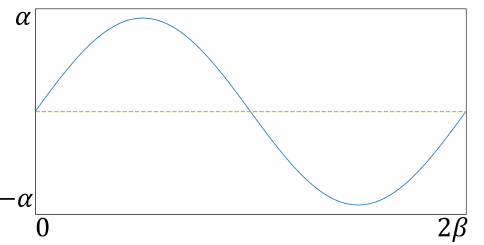
Figure 3. Contact surface motion